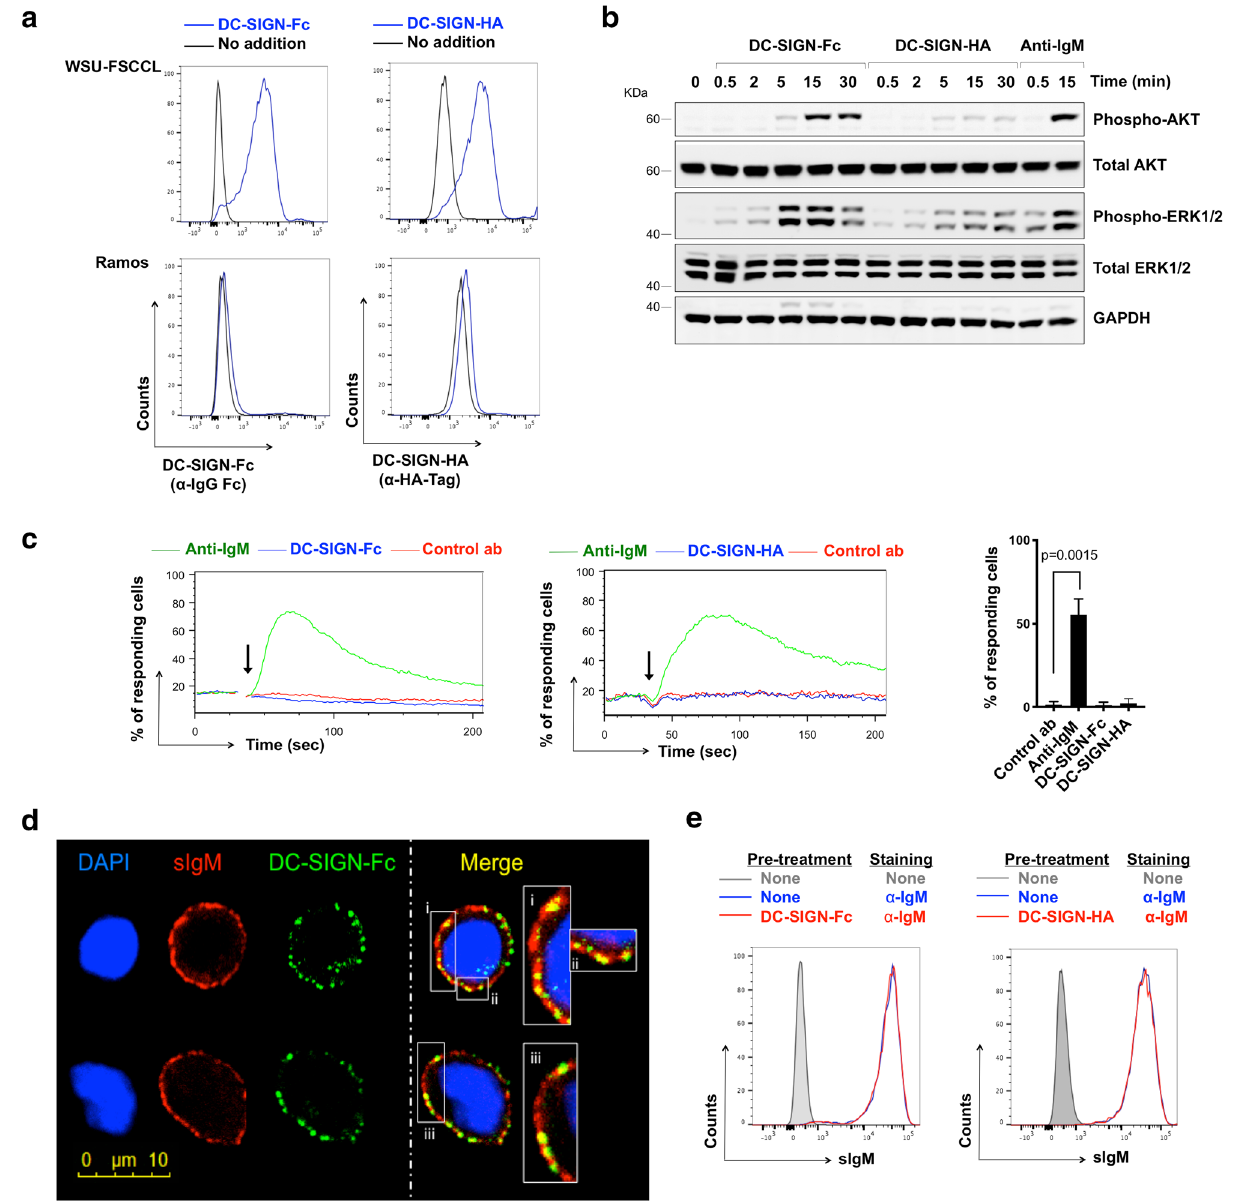
Figure 3. DC-SIGN binding and signaling in WSU-FSCCL cells. ( a ) Binding of DC-SIGN-Fc or DC-SIGN-HA to WSU-FSCCL and Ramos cells. Cells with no addition were analyzed as a control. Representative of 5 independent experiments. ( b ) WSU-FSCCL cells were incubated with DC-SIGN-Fc, DC-SIGN-HA, anti- IgM or left untreated as a control for 30 min at 4 °C and then warmed rapidly to 37 °C for the indicated times. Expression of total and phosphorylated AKT, ERK1/2 and GAPDH (loading control) was analyzed by immunoblotting. The gels were run under the same experimental conditions. Molecular weight of proteins markers shown as KDa. Results shown are representative of 3 independent experiments. Full-length blots are shown in Supplementary Fig. 3. ( c ) Representative iCa 2+ flux analysis after addition (arrow) of anti-IgM, DC-SIGN-Fc, DC-SIGN-HA or control antibody (control ab) and summary of data for 5 separate experiments. Graph shows mean (± SD) response with values for anti-IgM-treated cells set to 100%. The statistical significance of the indicated differences is shown (paired t-test) ( d ) Confocal imaging of bound DC-SIGN-Fc (green) and sIgM (red) on fixed WSU-FSCCL cells. Cells were incubated with DC-SIGN-Fc at 4 °C for 1 h and anti-IgM was added for the last 30 min. DAPI staining is shown in blue. Two representative cells shown. ( e ) Anti-IgM accessibility with DC-SIGN bound to BCR. FACS analysis of WSU-FSCCL cells incubated with DC-SIGN-Fc (left), DC-SIGN-HA (right) or no addition for 30 min at 4 °C and stained with FITC anti-IgM or left unstained as